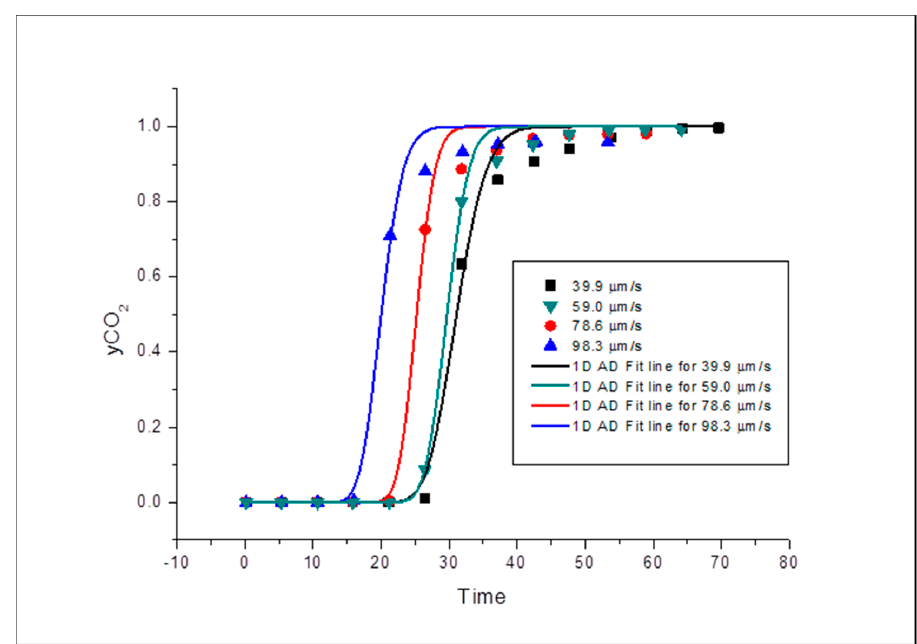
Figure 8. Concentration profile for Bandera Grey runs in vertical orientation.